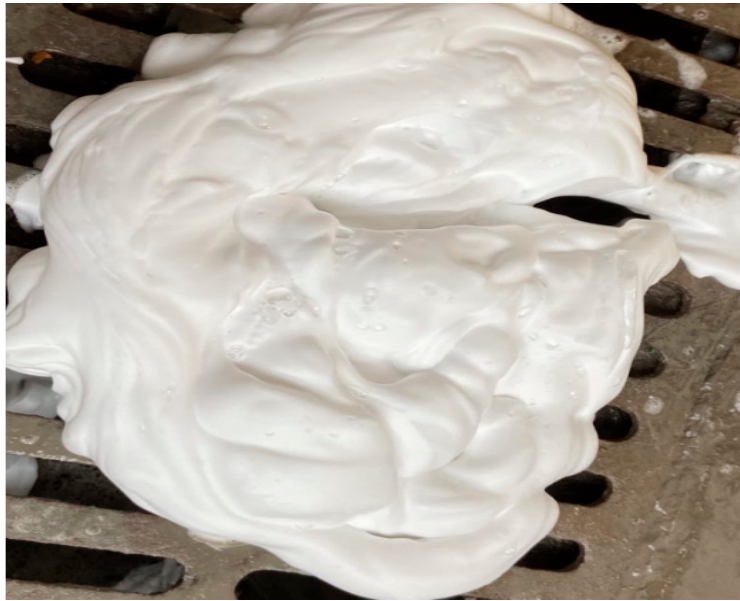
Figure 3. Foaming agent for HT foamed concrete.